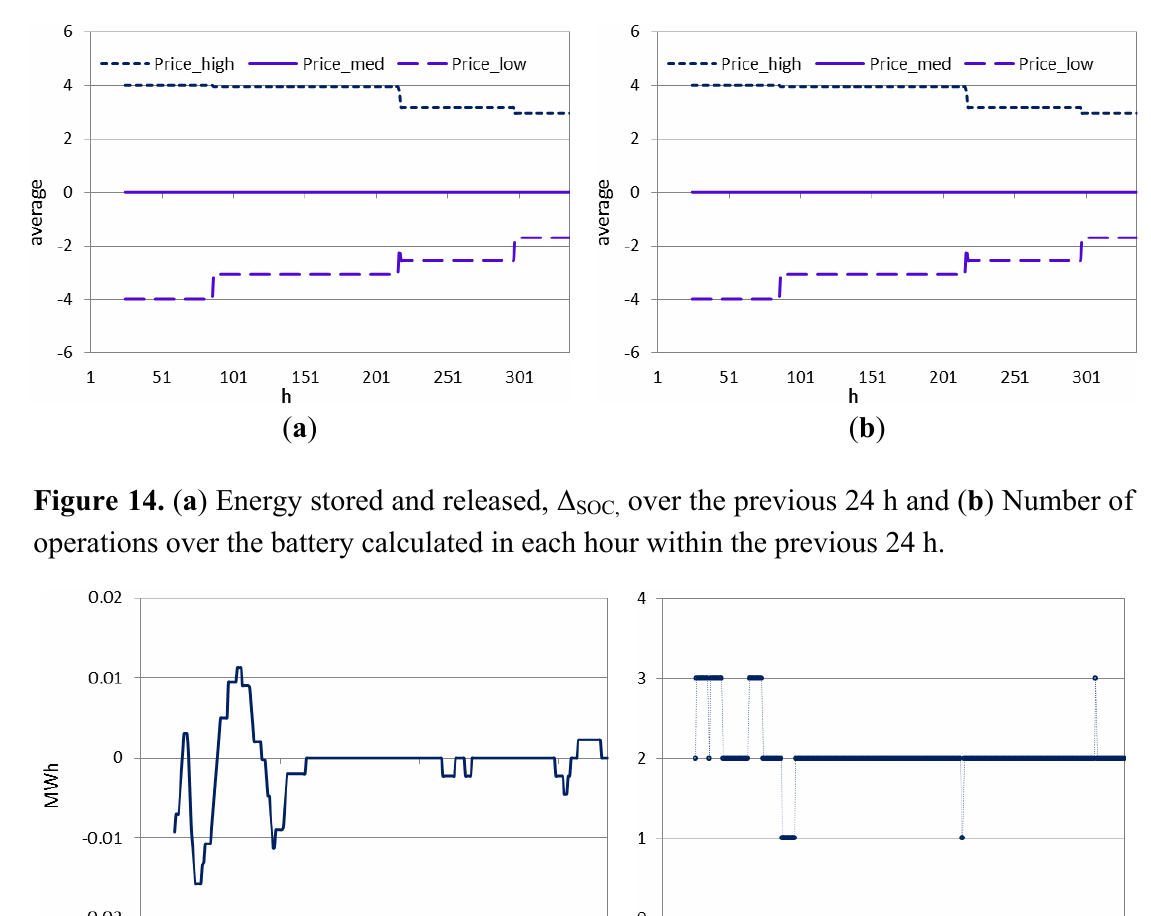
Figure 13. ( a ) Average parameters μ courses for Price_low, Price_med and Price_high MFs and ( b ) standard deviation parameters σ courses for Price_low, Price_med and Price_high MFs.